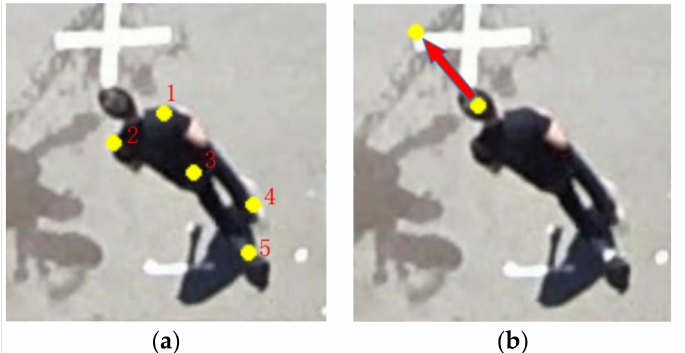
Figure 5. Image feature labeling: ( a ) 1–5 represent the edge of the right and left shoulders, center of the waist, right and left heels respectively; ( b ) the head position and head orientation